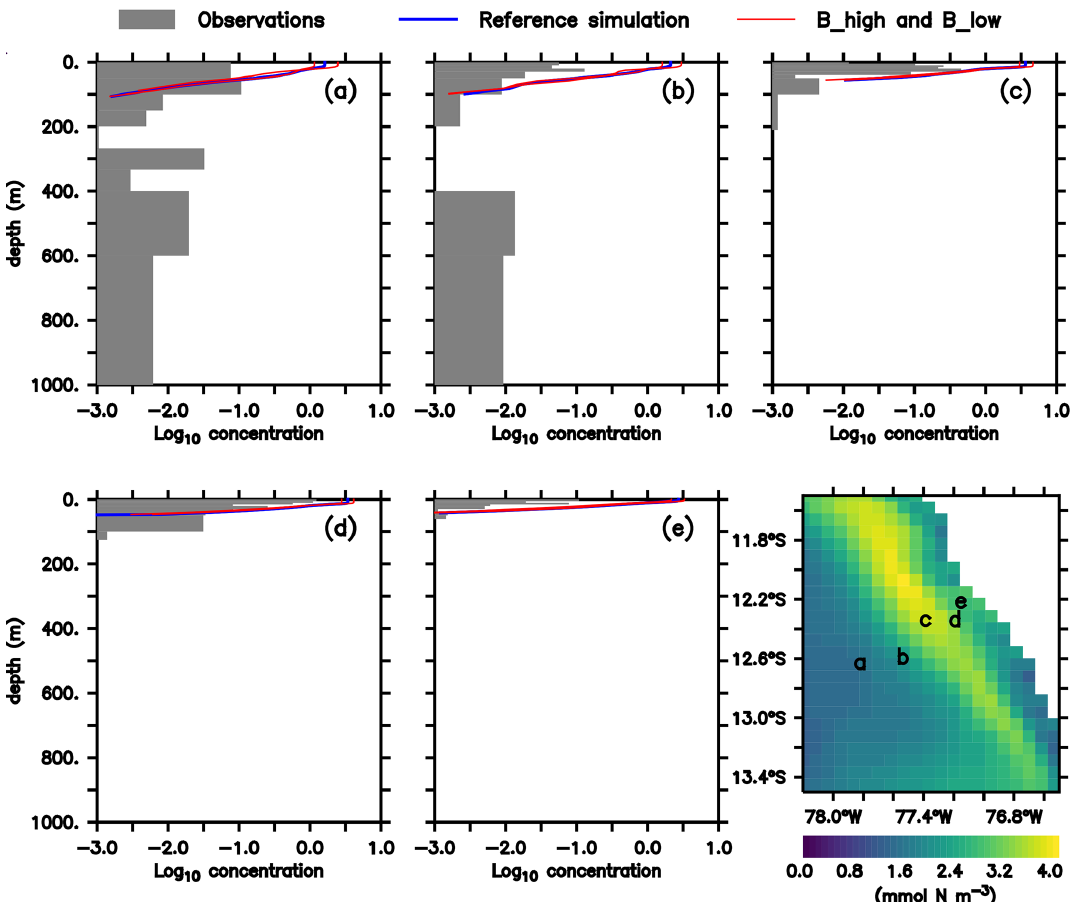
Figure B1. Same as Fig. 2, but (a–e) show a depth range up to 1000m and a logarithmic horizontal